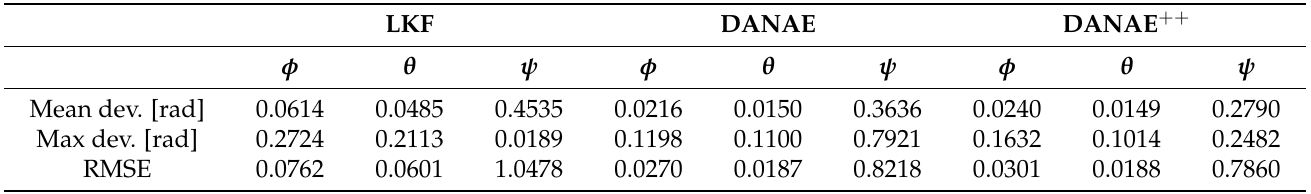
Figure 4. UCS Dataset: theta angle estimation provided by the LKF (top, light brown) and DANAE (bottom, light blue) compared to the GT (dark red). Table 3. OxIO Dataset: evaluation of the performances of the EKF, DANAE and DANAE ++ w.r.t. the GT for the three Euler